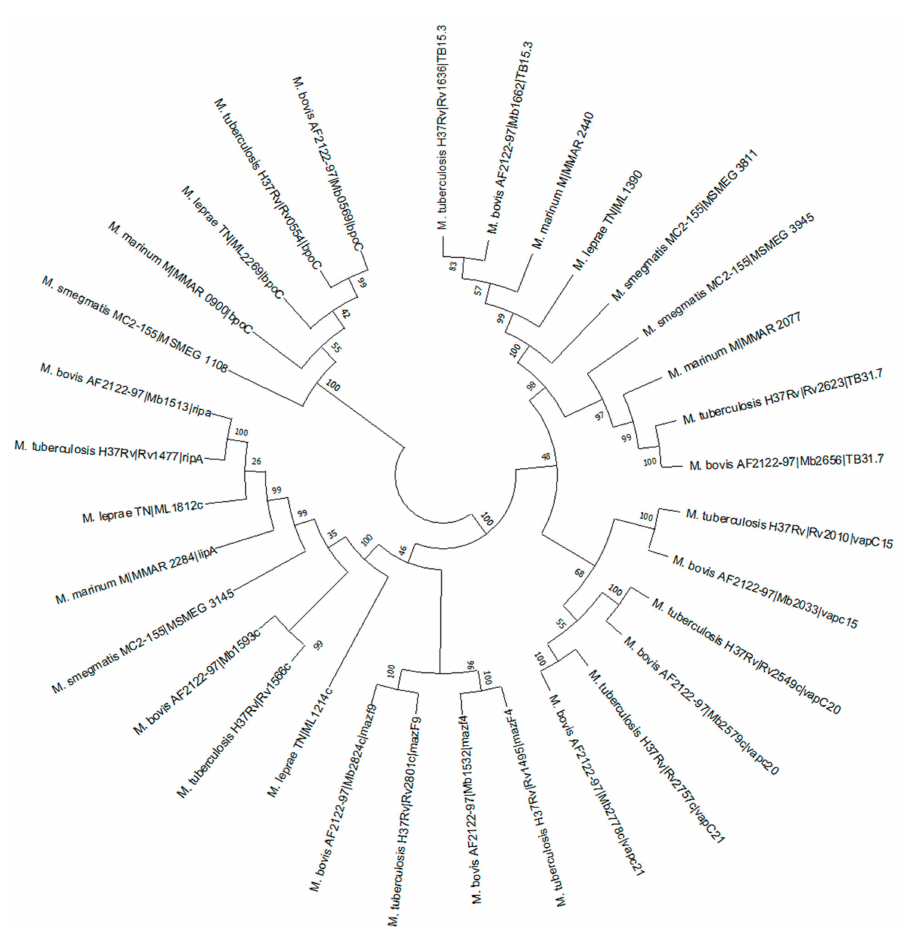
Figure 5. Phylogenetic tree depicting the relationships between virulence categories proteins in M. tuberculosis H 37